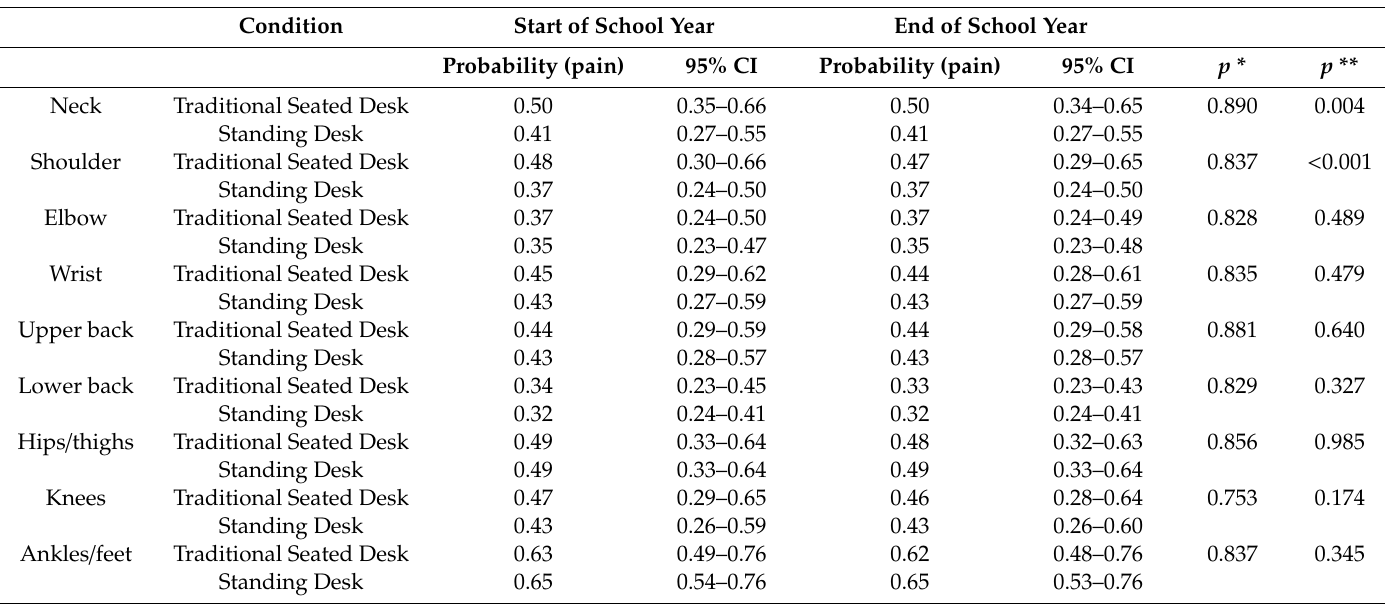
Table 2. Comparison of probability of reporting discomfort in di ff erent body regions between standing desk and traditional seated desk conditions and over time (start of school year and end of school